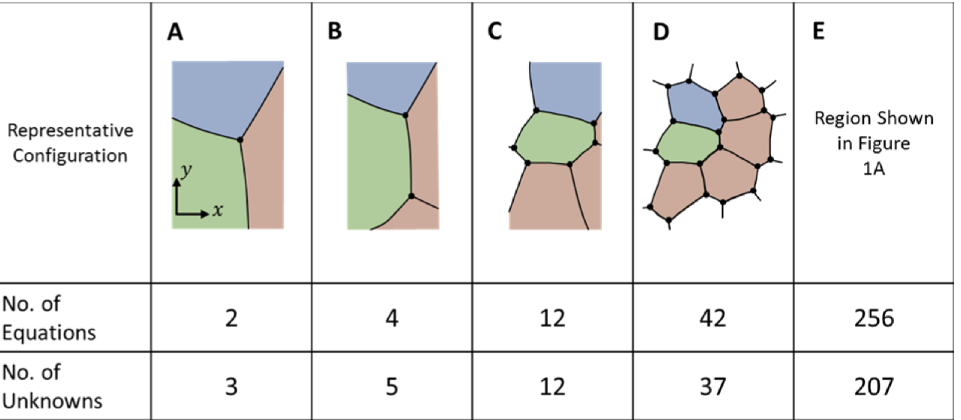
Figure 3. The tension equations are generally overdetermined. Geometric considerations show that the tension equations are, within a scale factor (see text), adequately determined ( A , and B ). When a full cell is enclosed ( C ) and as more cells become fully enclosed, they generally become increasingly overdetermined ( D and E ), though scaling information external to the image is still needed.